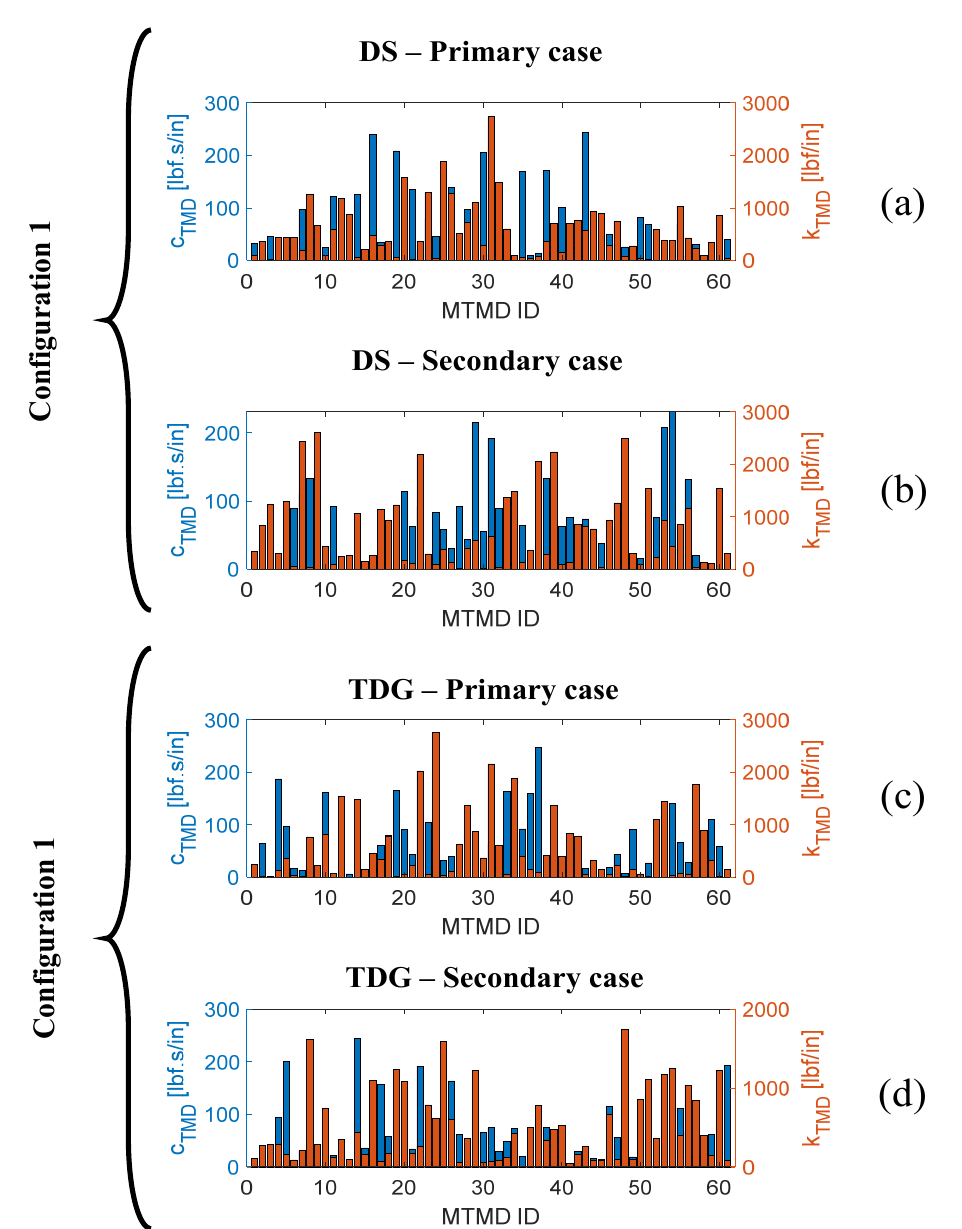
Figure 15. Summary of the MTMD Configuration 1 optimal damping and stiffness values, considering both operational cases modelled with the ( a , b ) PSD and the ( c , d ) TDG.